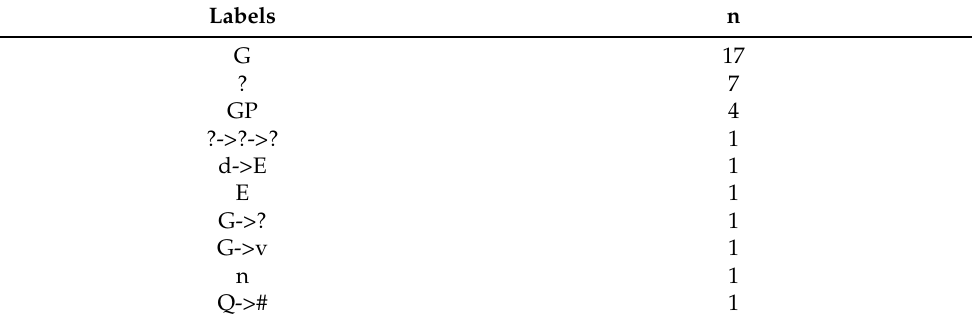
Table 5. Segment sequences for glottal filler